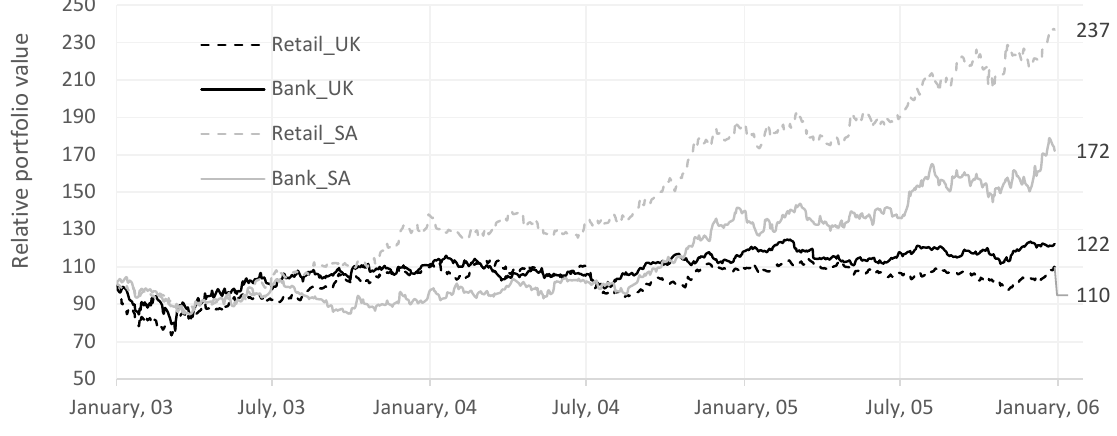
Figure 5. Relative portfolio development from 2003 to 2006.